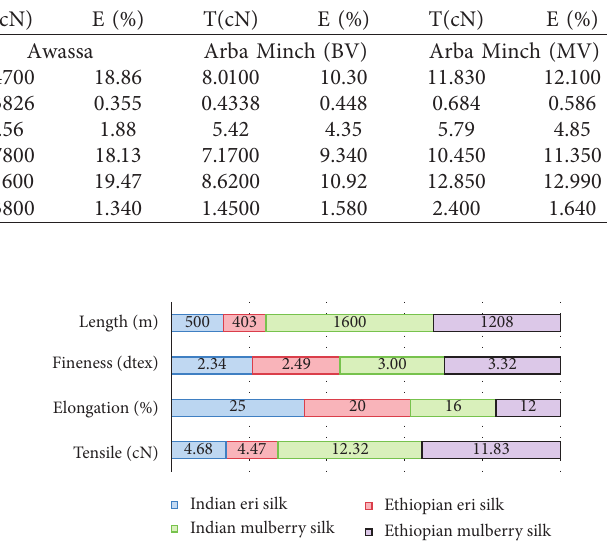
Figure 6: Comparison of Ethiopian and Indian (eri and mulberry) silk